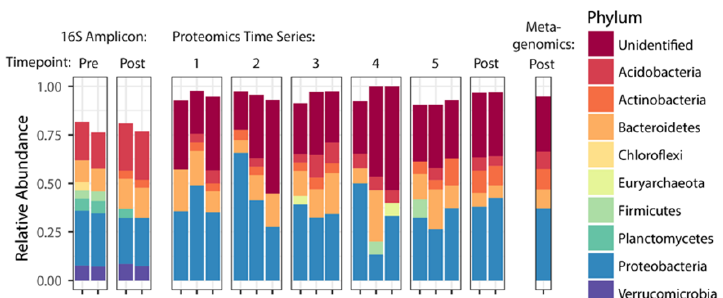
Figure 2. Taxonomic and functional profile of rhizosphere hot-spots. Taxonomy is based on SILVA database for 16S amplicons. The bulk metagenome from KBS, hotspot proteomic time series (1–5 represent days; Pre = beginning of the experiment or day 1; Post = Day 5), and the post (bulk ~5 g) metaproteome are based on RefSeq taxonomy from ATLAS.